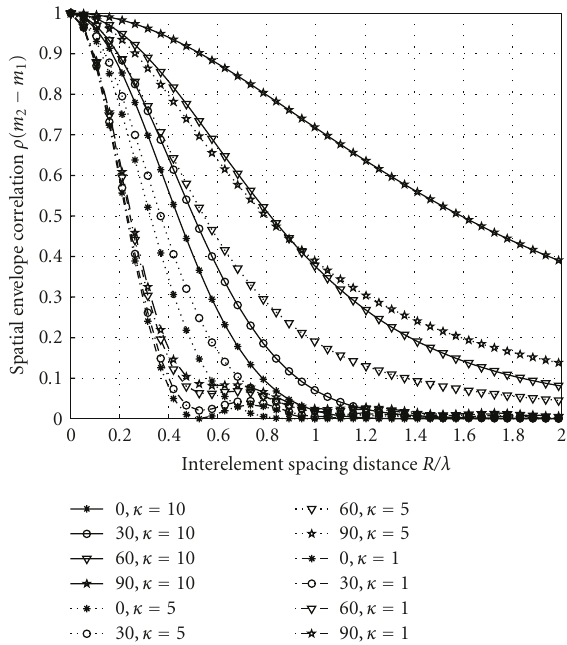
ff ect of the concentration parameter κ on the spatial correlation experienced between 2 elements located at 45 ◦ and 90 ◦ , respectively. Elevation is varied from ϑ o = 0 ◦ to 90 ◦ for a constant mean azimuth ϕ o = 337 . 5 ◦ and κ =